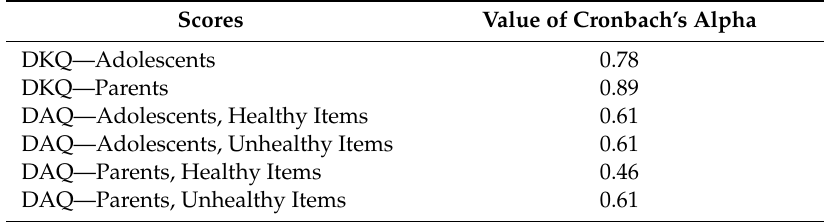
Table 4. Values for Cronbach’s alpha for the di ff erent questionnaire groups. Scores Value of Cronbach’s Alpha DKQ—Adolescents 0.78 DKQ—Parents 0.89 DAQ—Adolescents, Healthy Items 0.61 DAQ—Adolescents, Unhealthy Items 0.61 DAQ—Parents, Healthy Items 0.46 DAQ—Parents, Unhealthy Items 0.61